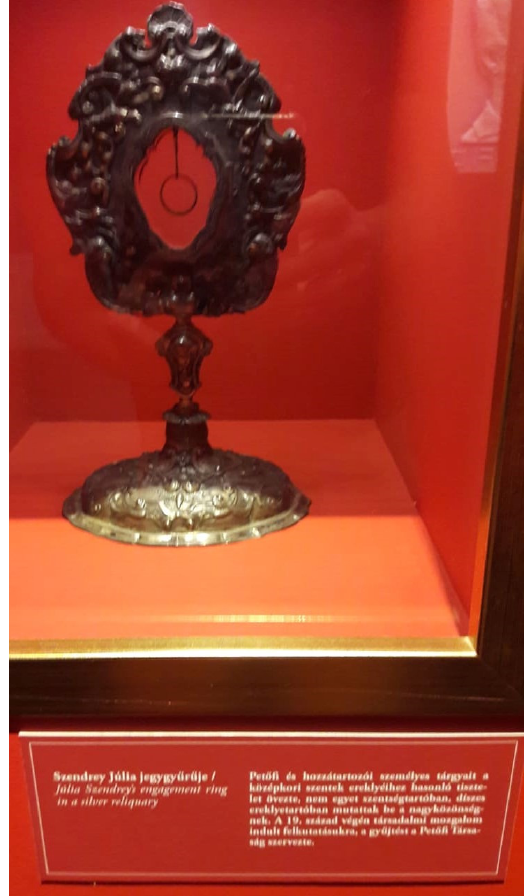
Figure 2. From the Pet ő fi Museum of Literature, Budapest. The text says “The personal objects of Pet ő fi and his relatives were venerated in a similar manner as the relics of medieval saints; some of them placed in ciboria or in ornate reliquaries for public display. At the end of the 19th century, a nationwide movement was organized to collect such items by the Pet ő fi Society”.